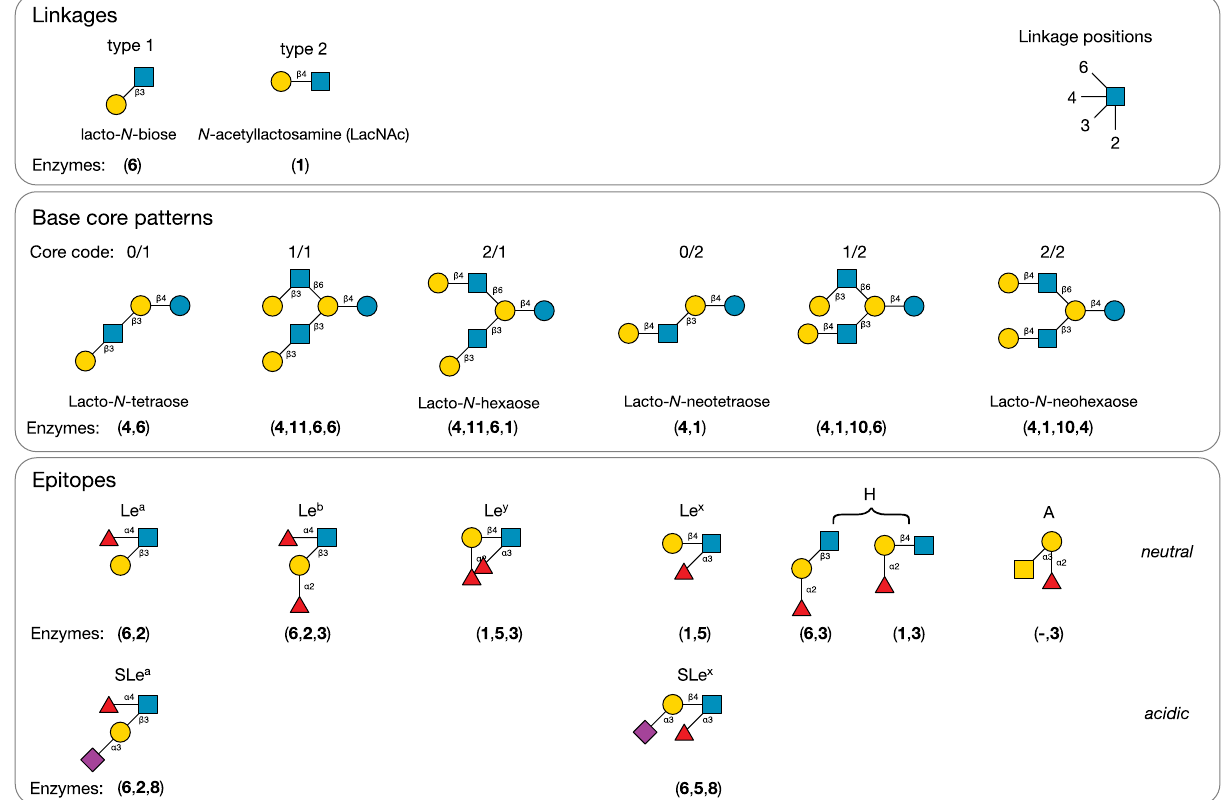
Figure 1. Structural motifs common to HMOs. Core structures are defined as lactose-based oligosaccharides that contain only hexose sugars, Glc and Gal, and the N -acetylhexosamine sugar, GlcNAc. Not all cores and epitopes are found within the experimentally determined HMO structures considered by this study. Base core patterns are defined as a / b , where a and b refer to the type-1 or -2 linkage of the terminal Gal, either to the 6-linked ( a ) or the 3-linked GlcNAc ( b ) of an I-antigen branch appearing on lactose. Proposed sequences of enzymes (indices of the enzymes in Table 2) involved in the biosynthesis of each motif are displayed beneath its structure. A complete set of core structures is in Supplementary Table